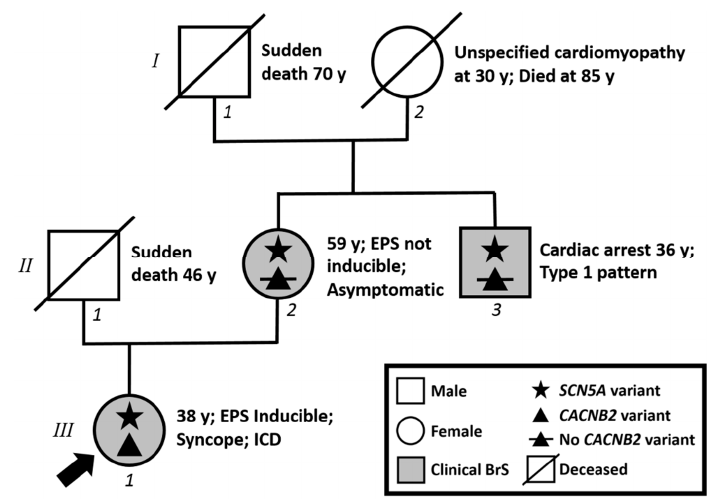
Figure 1. Family pedigree. Proband identified with arrow. Square: male; Circle: female; Shaded: clinically affected by Brugada syndrome; Star: molecularly confirmed SCN5A variant; Triangle: molecularly confirmed CACNB2 variant; Triangle with slash: negative for CACNB2 variant; y = years old at diagnosis.